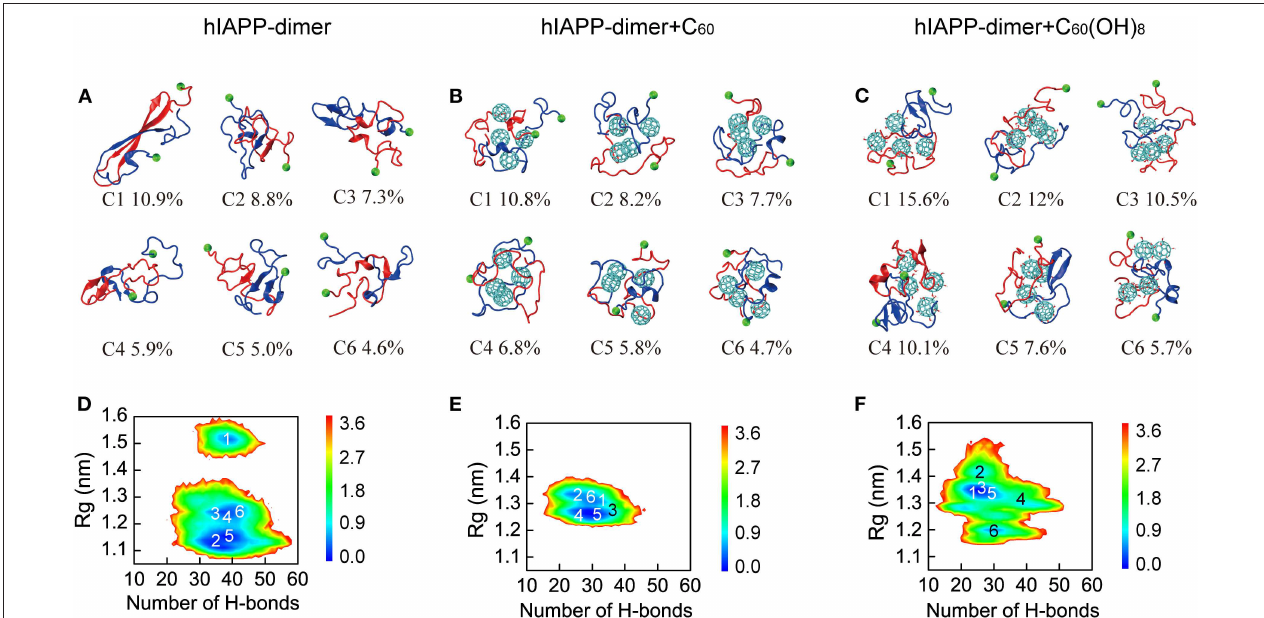
FIGURE 2 | Analysis of 3D conformational properties and 2D free energy landscape of hIAPP dimer with and without C 60 /C 60 (OH) 8 . Representative conformations of the first six most-populated clusters for hIAPP dimer in hIAPP-dimer (A) , hIAPP-dimer + C 60 (B) , and hIAPP-dimer + C 60 (OH) 8 (C) systems. The corresponding population of each cluster is given below the snapshots. Free energy landscape (in kcal/mol) of hIAPP dimer as a function of the total number of H-bonds and Rg for three systems (D–F) . The numbers in the PMF correspond to the cluster index. The green balls refer to the C α atoms of the N-terminal residue K1.